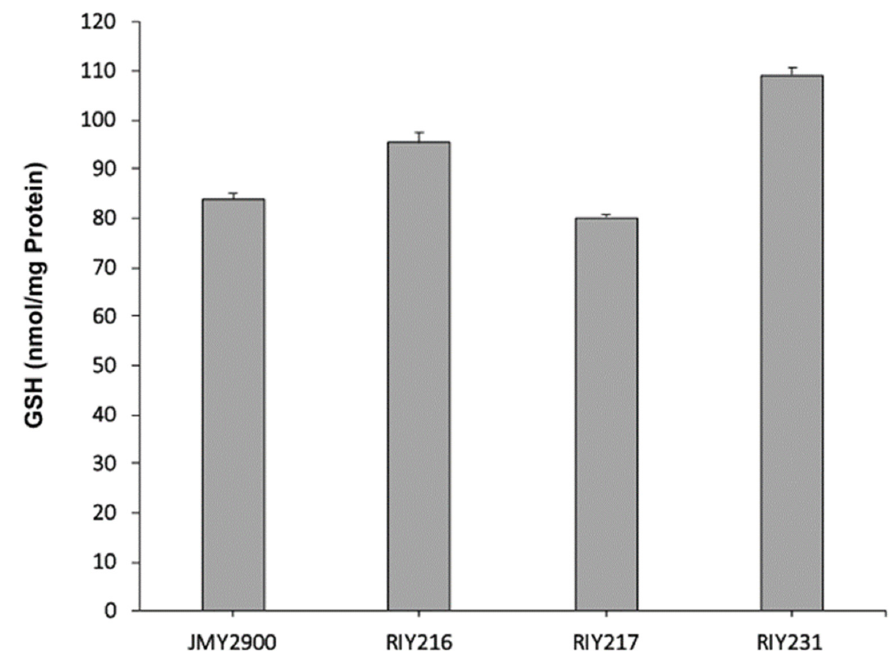
Figure 2. γ - l -glutamyl- l -cysteinyl-glycine (GSH) production of Y. lipolytica strains JMY2900 (WT), RIY216 (p TEF - ylGSH1 ), RIY217 (p TEF - ylGSH 2) and RIY231 (p TEF - ylGSH 1- ylGSH 2) grown in YPD for 24 h. Data are the mean and standard deviation of three experiments. The glutathione titer value was expressed in nmol per mg of protein (nmol/mg protein).